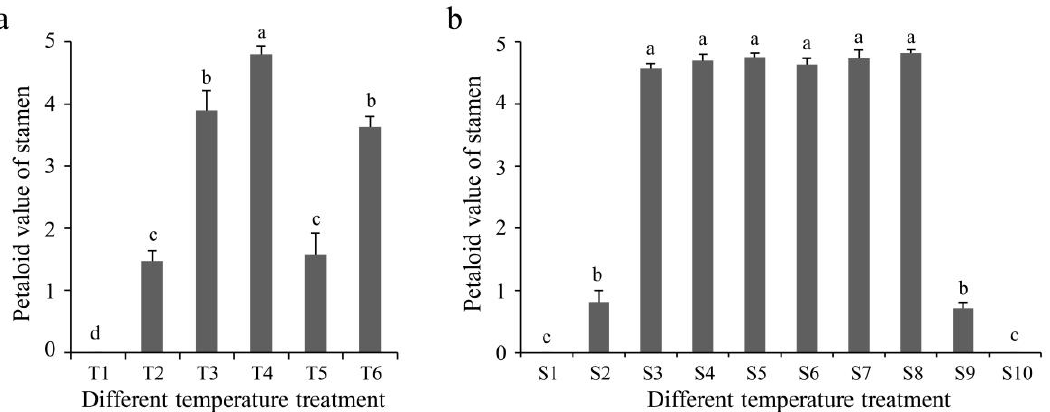
Figure 3. The petaloid value of stamens at the blooming stage under different temperature treatment T1-T6 (a) and S1-S10 (b). All treatments are explained in Figure 1. The petaloid value of the stamen was calculated according to Table 2. Different letters above bars indicate significant differences at the 0.05 level (Tukey-Krammer test).